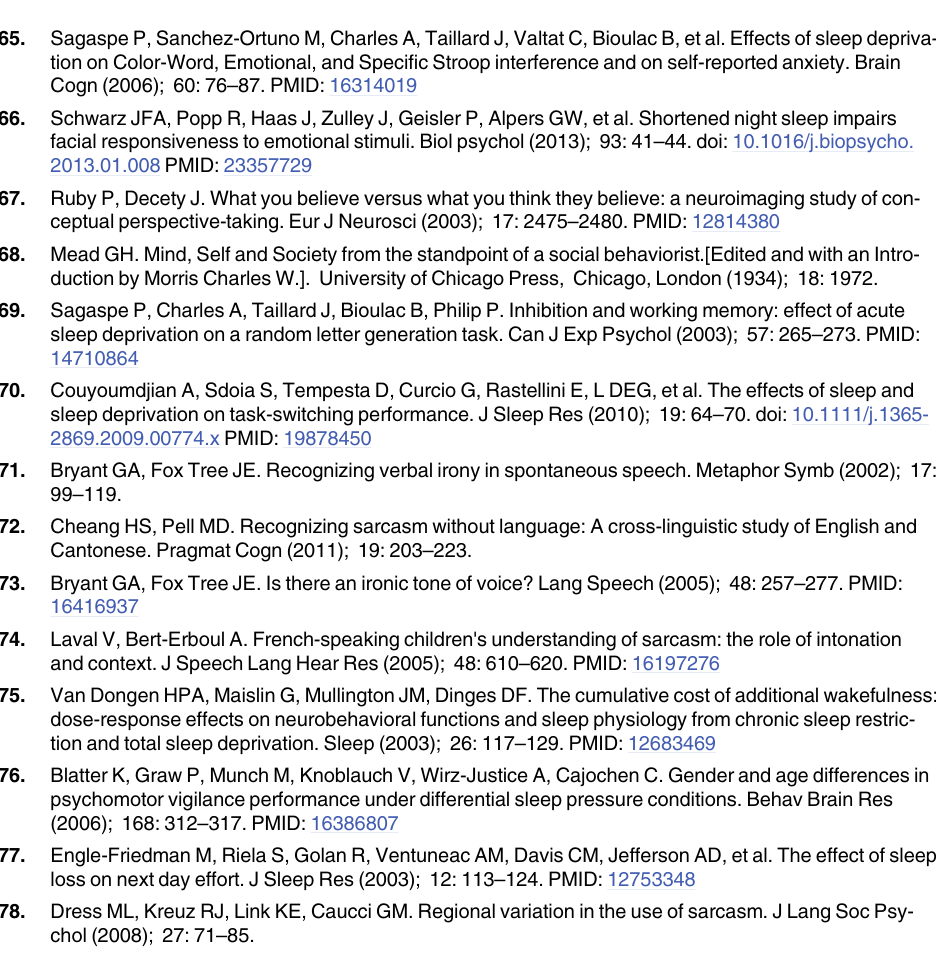
PLOS ONE | DOI:10.1371/journal.pone.0140527 November 4,